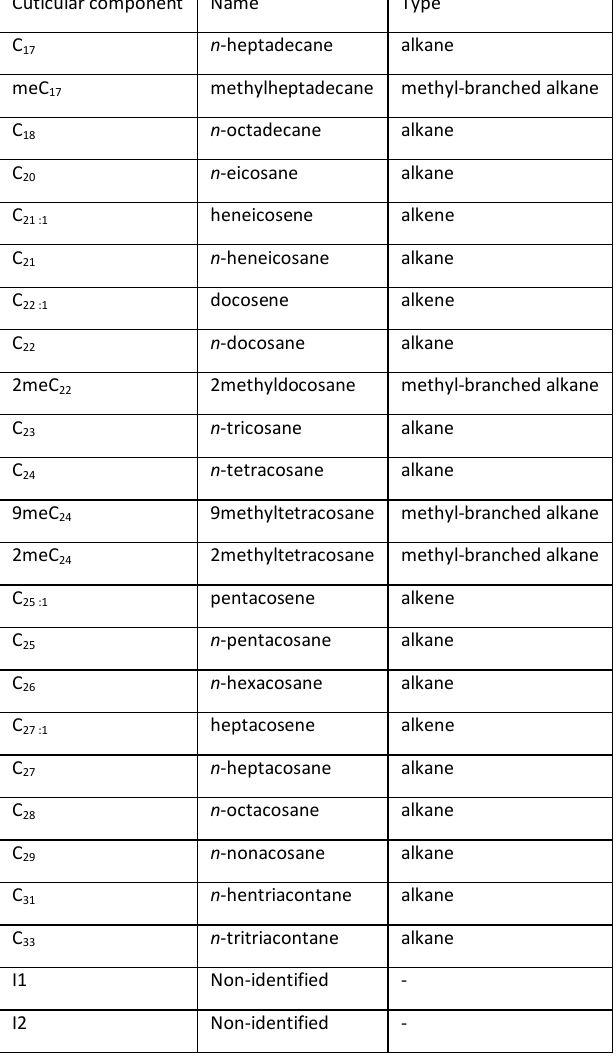
Table 1 : List of detected compounds in the cuticle of I. uriae adult female ticks, including name and type. Cuticular component